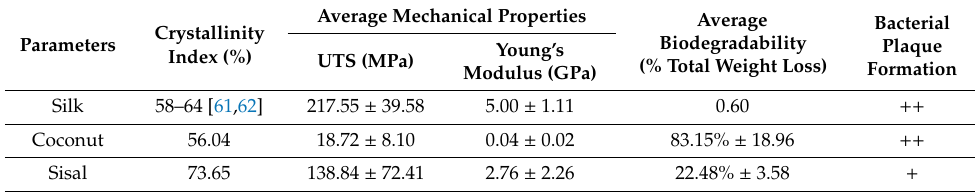
Table 2. Summary table of mechanical properties, biodegradation, and antifouling capacity for coconut, sisal, and silk. (the sign + is related to the degree of bacterial plaque